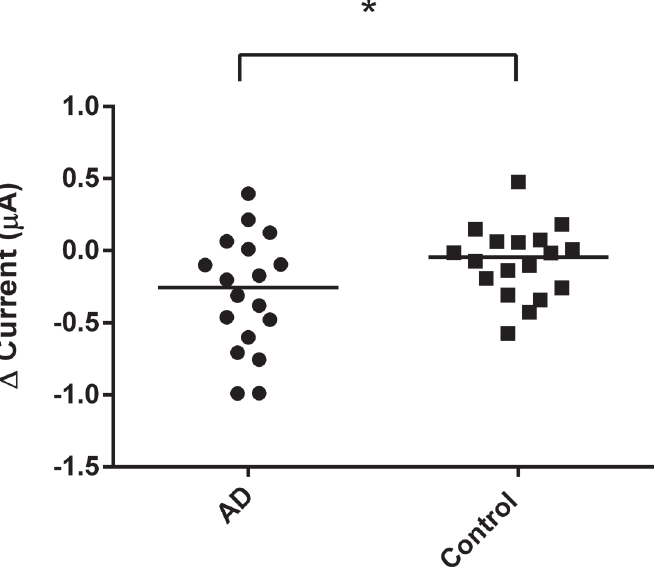
Fig 5. Change in EG-ISFET biosensor currents for AD and control saliva samples. The change of current generated from the AD and control groups. Data are presented as median. * p (cid:1) 0.05.